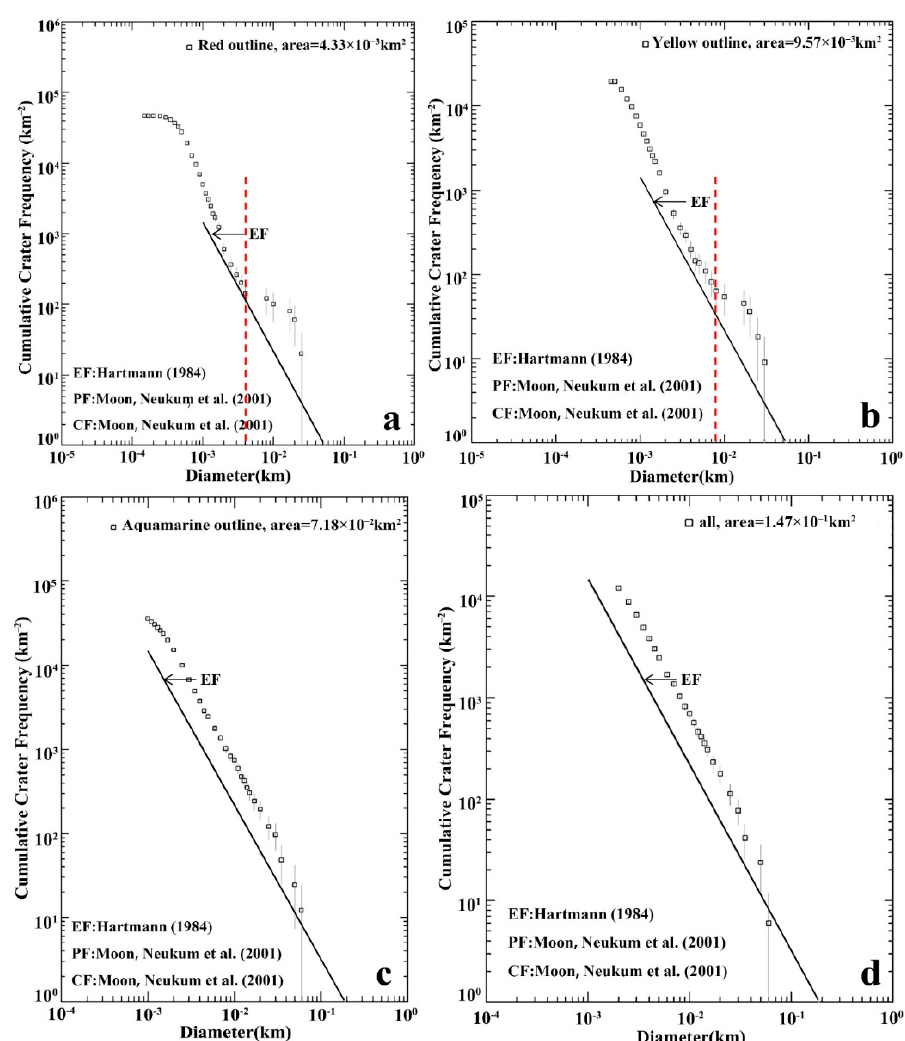
Figure 11. Craterstats2 program calculated cumulative SFD and equilibrium lines in the red, yellow, aquamarine, pink outlined areas. EF refer to the equilibrium function of Hartmann [44]. PF and CF refer to the production function and the chronology function of Neukum et al. [48], respectively. Red dashed lines show the inflection points. The equilibrium lines (criterions from Hartmann [44]) are displayed as black lines in ( a – d ). ( a ) Red outlined area. ( b ) Yellow outlined area. ( c ) Aquamarine outlined area. ( d ) Pink outlined area.